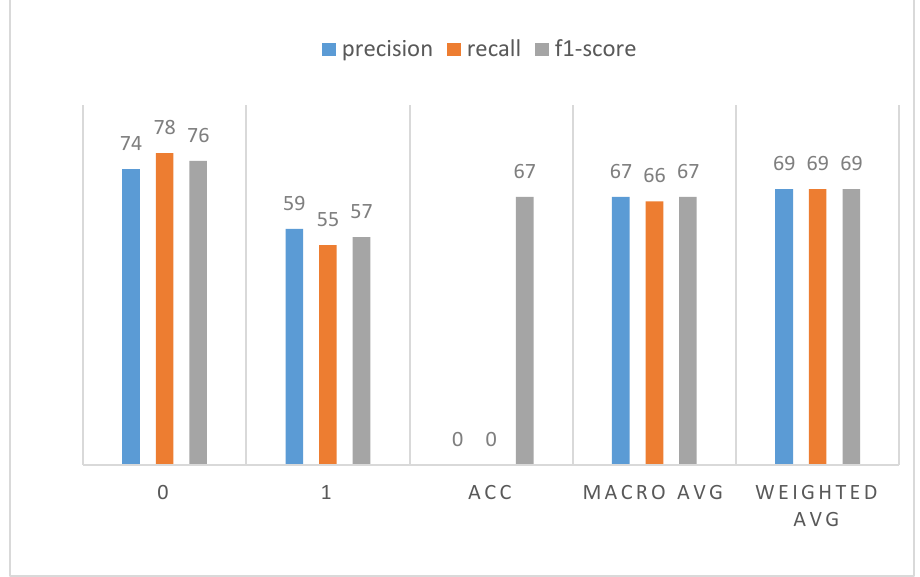
Figure 12. Summary of results for a testing dataset equal to 30% and training dataset of 70%. For the testing dataset size of 30% and training dataset size of 70% (Figure 12), one parameter — precision for the lower limit — decreased. For the other values, there was no significant decrease or increase.